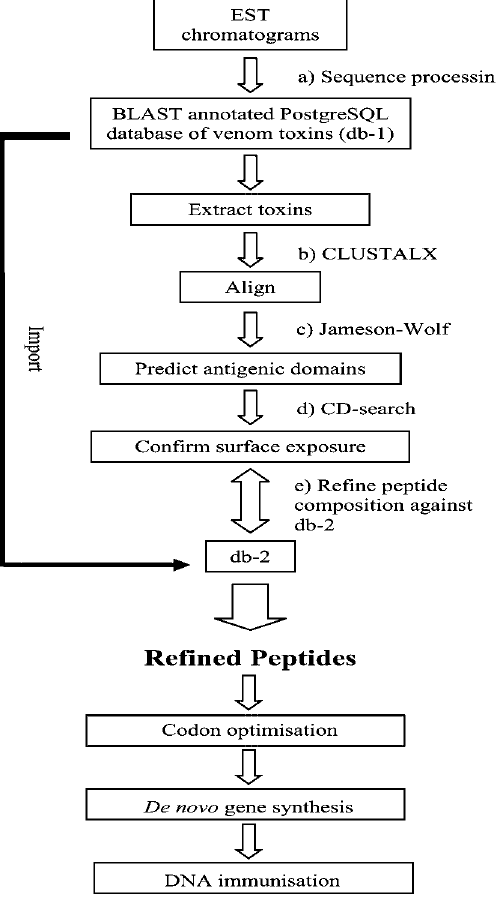
Figure 1. The Bioinformatic Pipeline Used to Identify Immunogenic Peptides EST chromatograms (A) are trimmed for contaminating sequences by trace2dbest, imported into PartiGene [25], clustered using CLOBB [26], BLAST-annotated, and finally used to populate db-1. Toxins are extracted and aligned using CLUSTALX (B) before (C) antigenic predictions by Jameson-Wolf (C) and three-dimensional superposition using CD-search (D). Peptide composition was refined against db-2 (E) before sequence incorporation into synthetic codon optimized DNA constructs for immunization (db,